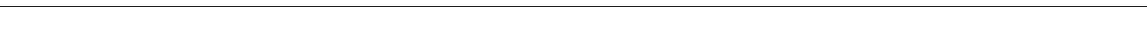
Fig. 4 DOT1L inhibition modulates ERK phosphorylation by downregulating miR-181a and consequently increasing DUSP6 expression. a CD8 + T cells transduced with a low-af fi nity A2/MART1 TCR (clone 413) were treated with SGC0946 or DMSO and stimulated with the aAPC/A2 loaded with A2/ MART1 27 – 35 peptide. The mean fl uorescence intensity (MFI) of the indicated phosphoproteins in the TCR-transduced T cells was analyzed ( n = 4 cultures, unpaired two-sided t -test). b Gene expression pro fi les of CD8 + T cells treated with SGC0946 or DMSO for 14 days were compared by RNA sequencing ( n = 3). c , d DUSP6 expression in SGC0946-treated T cells relative to control T cells was analyzed with qPCR ( c , n = 8; one sample t -test) and immunoblotting ( d , representative blots and quanti fi ed protein levels, n = 4, one sample t -test). e The MFI of phospho-ERK in SGC0946- or DMSO-treated T cells after stimulation with PMA/ionomycin ( n = 4 different donor samples, paired two-sided t -test). f , g CD3 + T cells were transduced with DUSP6- IRES- Δ NGFR or control Δ NGFR and treated with SGC0946 or DMSO. T cells were labeled with CFSE and cocultured with allogeneic PBMCs. The frequencies of dividing cells ( f ) and CD69 + cells ( g ) in the Δ NGFR + CD8 + T-cell population were analyzed ( n = 4 cultures, ordinary one-way ANOVA with Tukey ’ s multiple comparisons test). h , i CD8 + T cells transduced with DUSP6-IRES- Δ NGFR or control Δ NGFR were transplanted into NSG mice. The frequencies of Δ NGFR + / − CD8 + T cells in peripheral blood ( h ) and CD45RA + CD62L + CCR7 + cells within the indicated populations ( i ) were analyzed on day 10 ( n = 8 mice, unpaired two-sided t -test). j Relative expression of miR-181a in SGC0946-treated T cells compared with control T cells ( n = 6, one sample t -test). k , l SGC0946- or DMSO-treated T cells were transfected with a miR-181a mimic. DUSP6 expression was analyzed by immunoblotting. Representative blots ( k ) and quanti fi ed protein levels relative to DMSO control samples are shown ( l , n = 4, repeated measures one-way ANOVA with Tukey ’ s multiple comparisons test). m Chromatin samples from SGC0946- or DMSO-treated T cells were immunoprecipitated with an anti-H3K79me2 antibody. The enrichment of H3K79me2 around the transcription start site of miR-181a was analyzed with qPCR ( n = 5, paired two-sided t -test). NS, not signi fi cant. Horizontal lines indicate the means ±